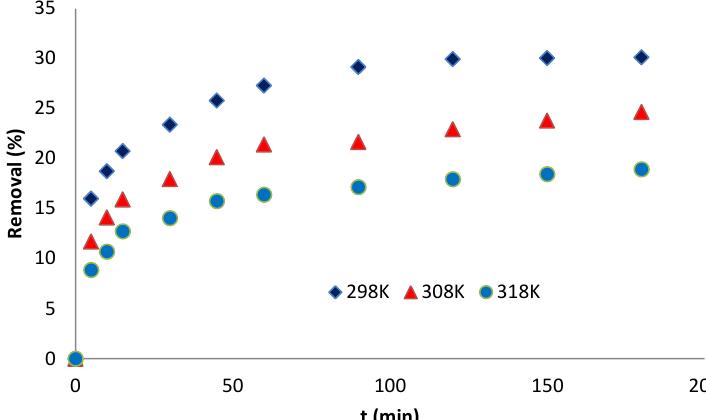
Fig. 7. The effect of temperature on the adsorption of MB on 5-SA-TiO2 nanoparticles (initial concentration 200 mg/L, pH = 6, and contact time